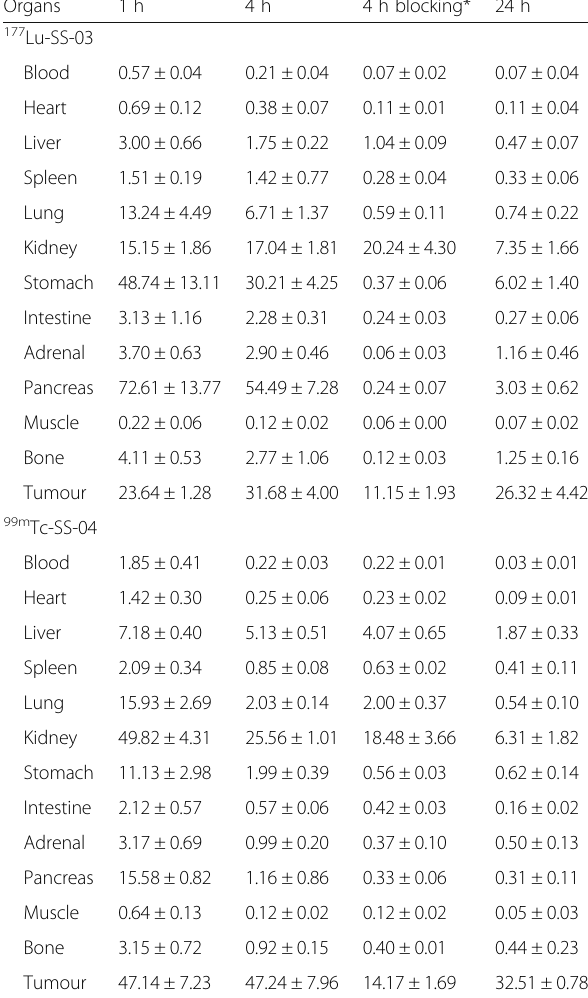
Table 3 Biodistribution results of 177 Lu-SS-03 and 99m Tc-SS-04 in nude mice bearing HEK293-rsst2 tumour xenografts. Data expressed as %IA/g (percentage of injected activity per gram) and presented as mean ± SD ( n = 3 –